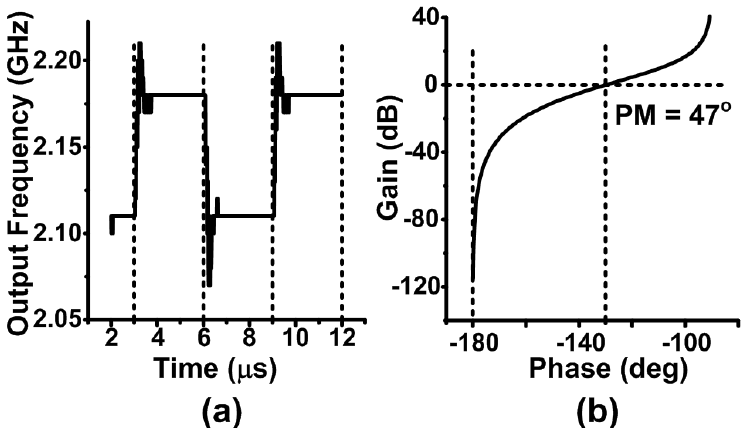
Figure 5. ( a ) Simulated response to step changes in the reference frequency showing a settling time less than 1.5 μs. ( b ) Nichols chart showing the stability of the system.